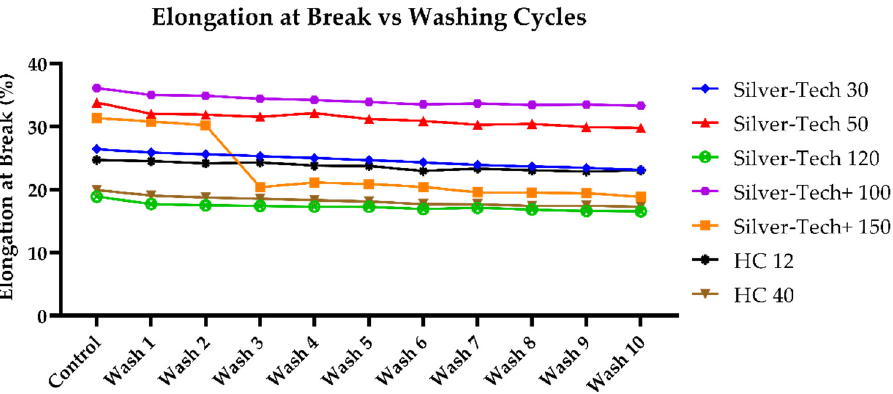
Figure 8. Change in elongation at break after washing across all tested thread samples without pro- tective polyamide thread on top.